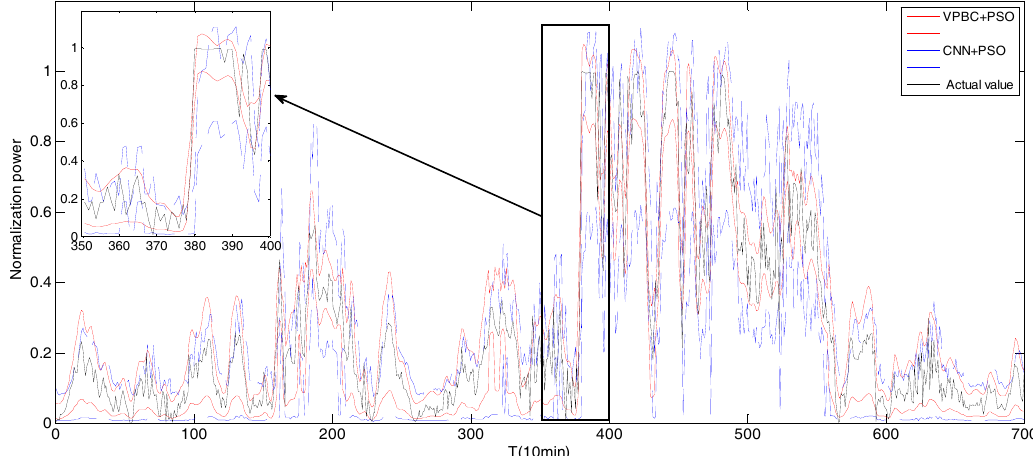
Figure 8. Forecasting results of the VPBC + PSO and CNN + PSO methods at 85% PINC.